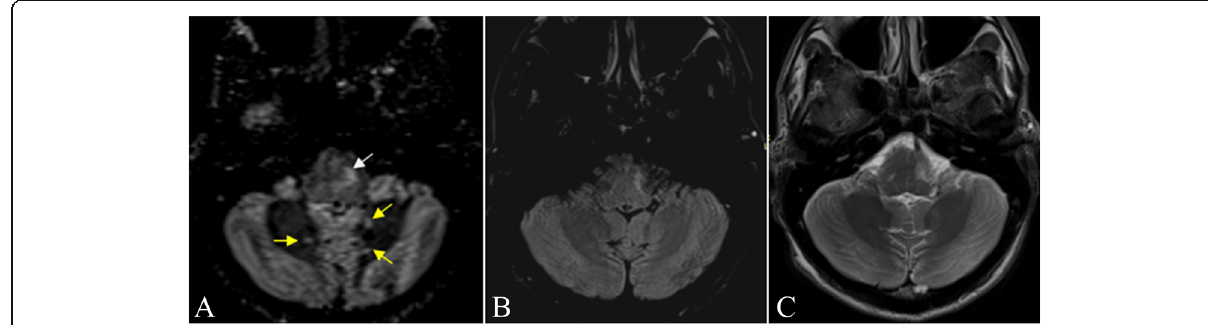
Fig. 1 Axial MRI of brain at the level of medulla oblongata. A hyper-intense lesion observed in the left aspect of medulla oblongata with better delineation on DIR ( a ) compared to FLAIR ( b ), and T2WI ( c ). Also, several small hyper-intense juxtacortical lesions (yellow arrows) are seen involving bilateral cerebellar white matter that are identified on DIR ( a ) and not seen on both FLAIR ( b ) and T2WI image ( c